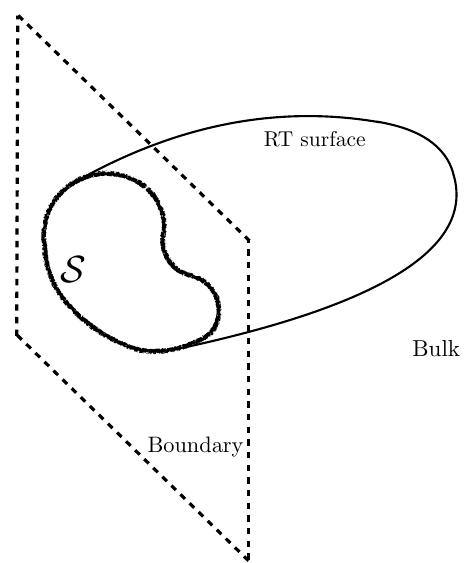
Figure 3 . Illustration of the Ryu-Takayanagi prescription for computing entanglement entropies. The dotted square represents a regularized version of the boundary, in which the entangling surface sits. The RT surface is anchored in , extends into the bulk, and has minimal S S